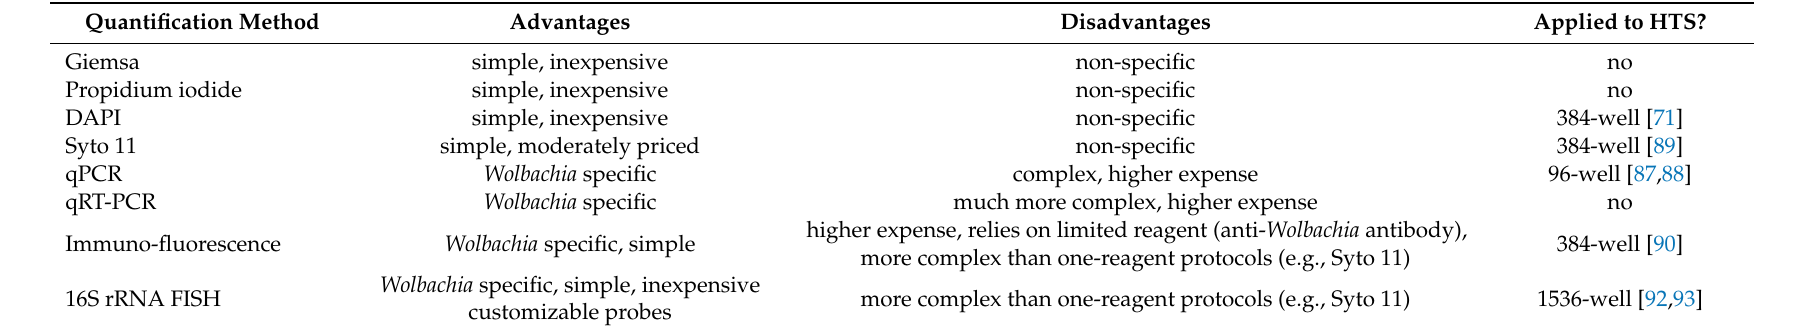
Table 6. Wolbachia visualization and quantification methods and their utility in high-throughput